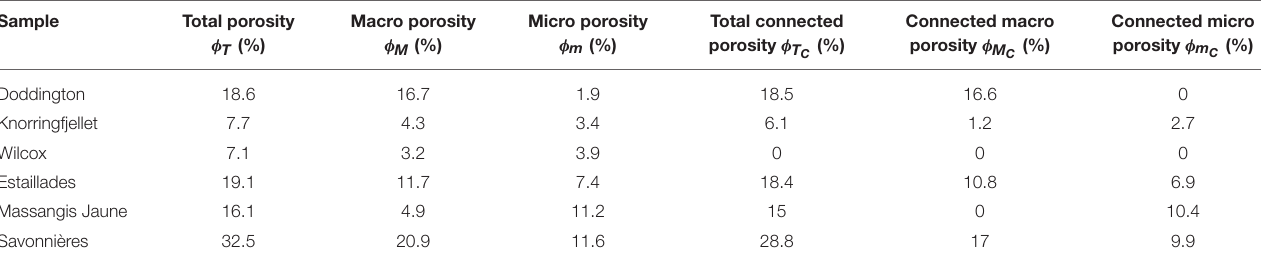
TABLE 2 | Volume fraction of total porosity ( φ T ), macroporosity ( φ M ), microporosity ( φ m ), total connected porosity ( φ T microporosity ( φ m ) of total smple volumes. C